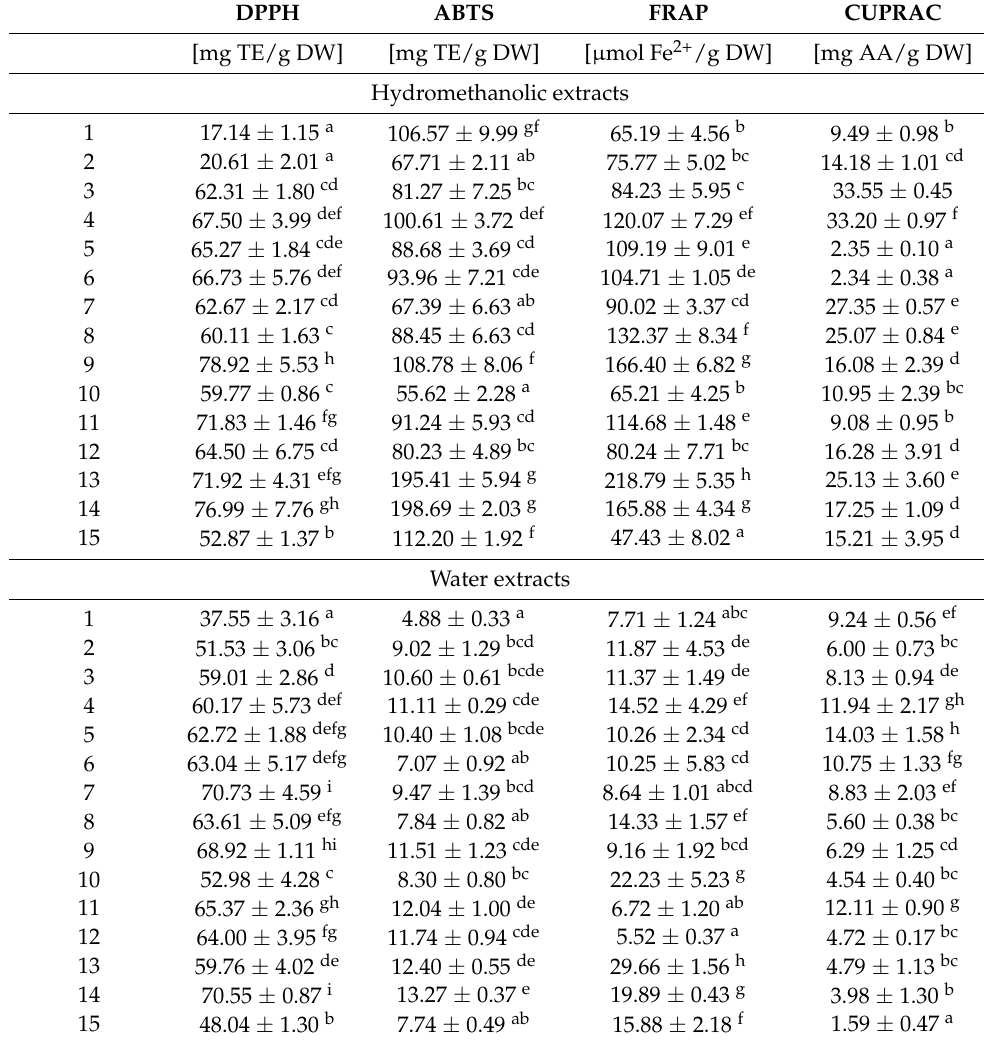
Table 5. The results of DPPH, ABTS, FRAP, and CUPRAC in R. rosea commercial